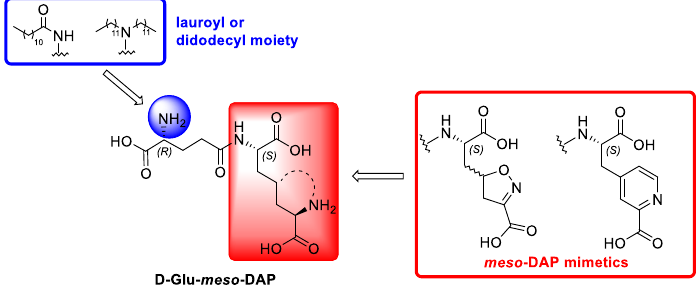
Figure 1. Design of conformationally constrained d -Glu- mes o-DAP analogs carrying meso -diaminopimelic acid ( meso -DAP) mimetics.